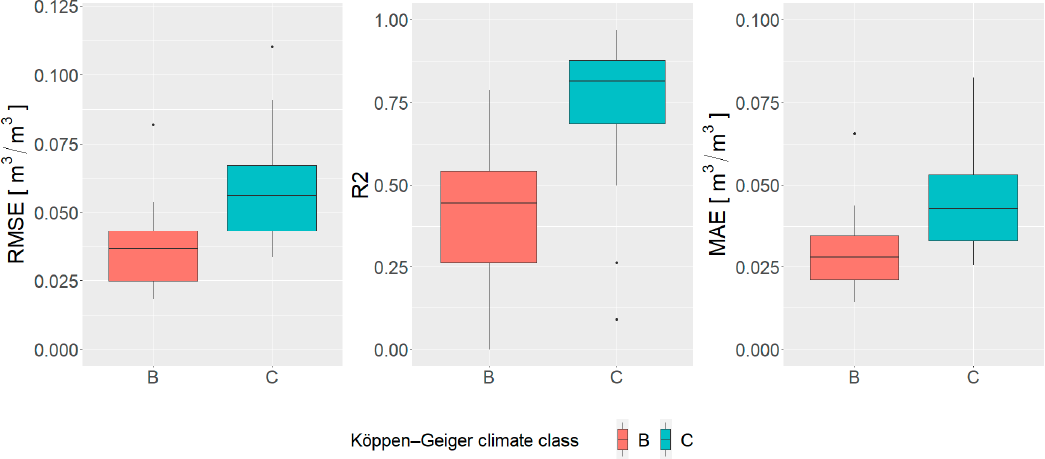
Figure 10. Boxplot of the calculated metrics (without NDVI shift) per stations differentiated by climate classes.